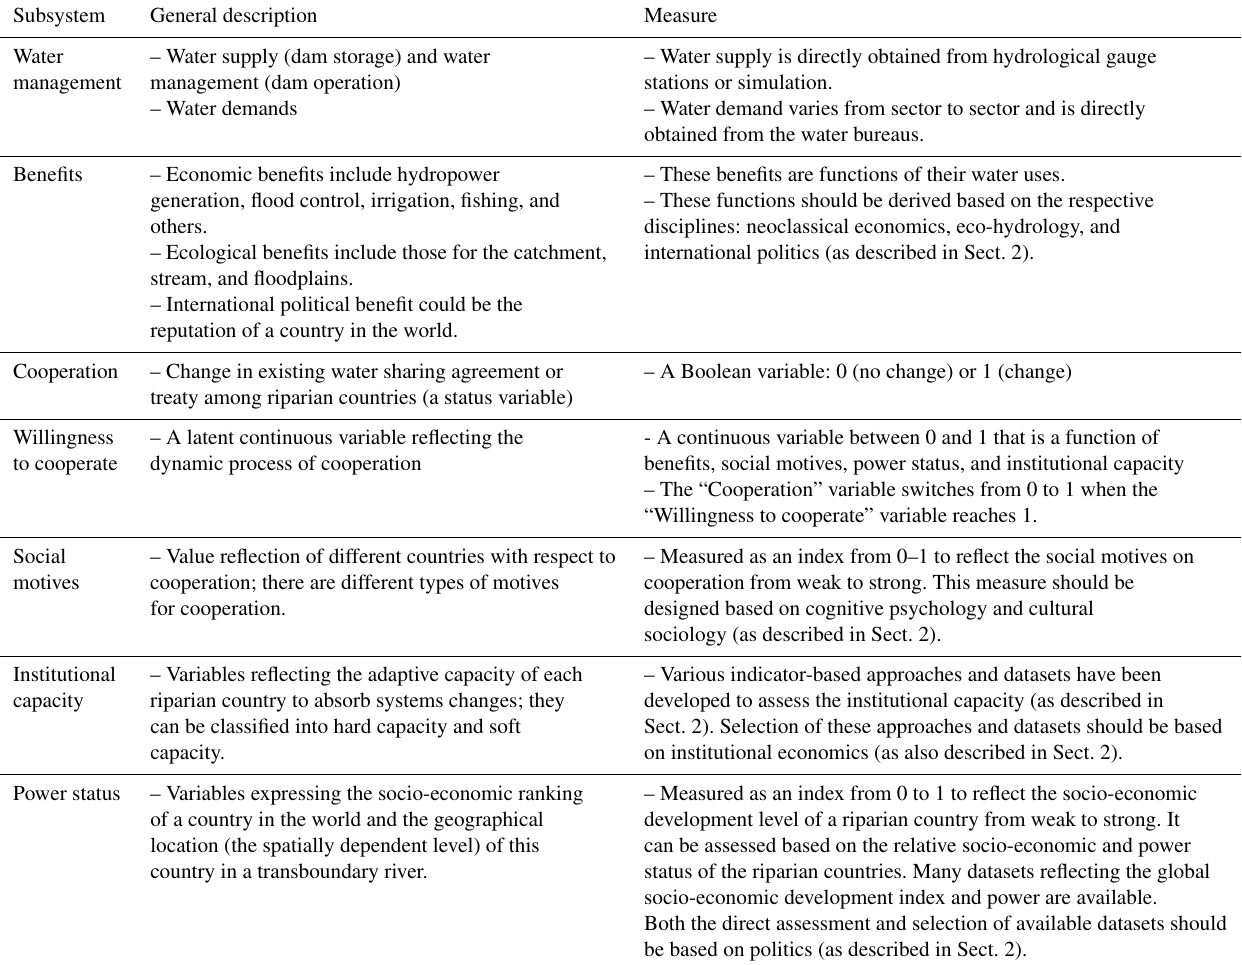
Table 2. The description and measures of each subsystem in the framework concept.